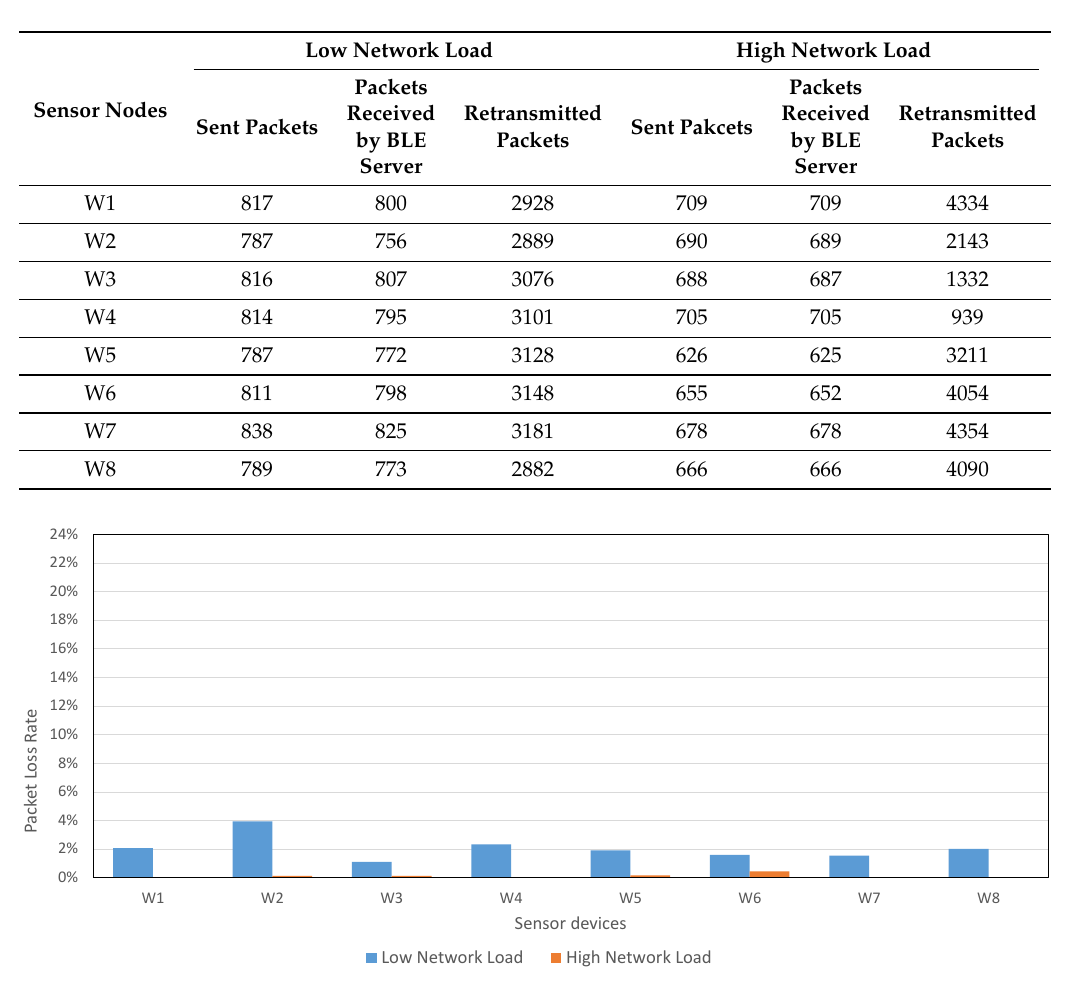
Table 14. Number of packets sent and retransmit by each sensor node and received by BLE server, for each Waspmote device configuration in Collaborative Mesh with CSR devices retransmit each packet three times.